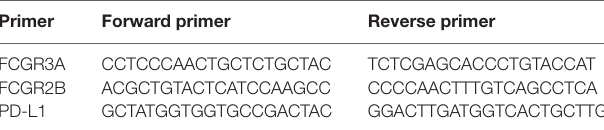
TaBle 2 | Primer sequences (5 ′ –3 ′ ). Primer Forward